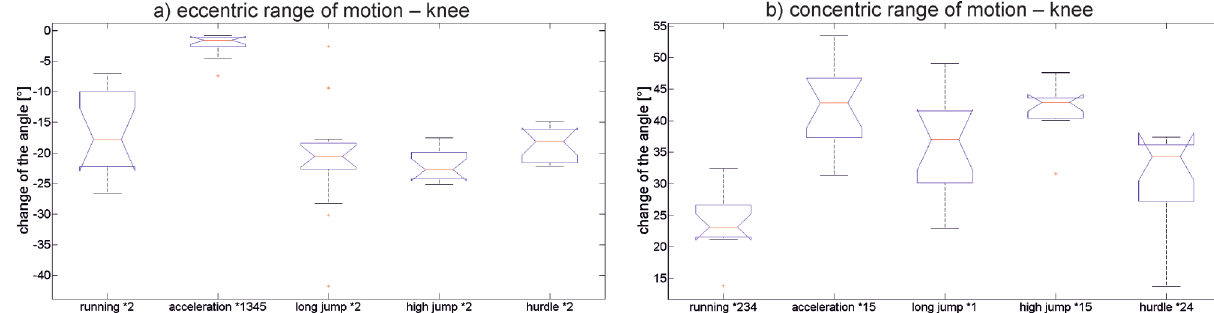
Figure 4. Eccentric (a) and concentric (b) range of motion in the knee joint. Box graphs display the distribution of values of each type of the jump. Significant differences ( p < .05) are denoted with * and numbered with relation to the take-off type: 1 – running, 2 – acceleration running, 3 – long jump, 4 – high jump, 5 –